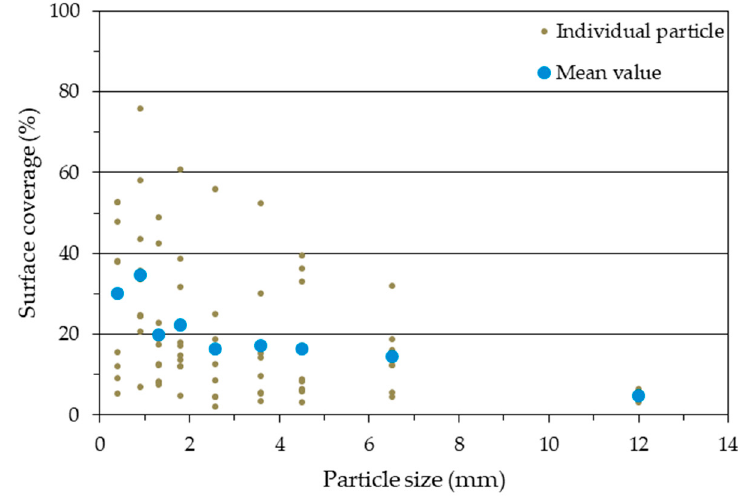
Figure 11. Mean and individual values of the surface coverage of the individual particles from PM 2 (AC 8%).